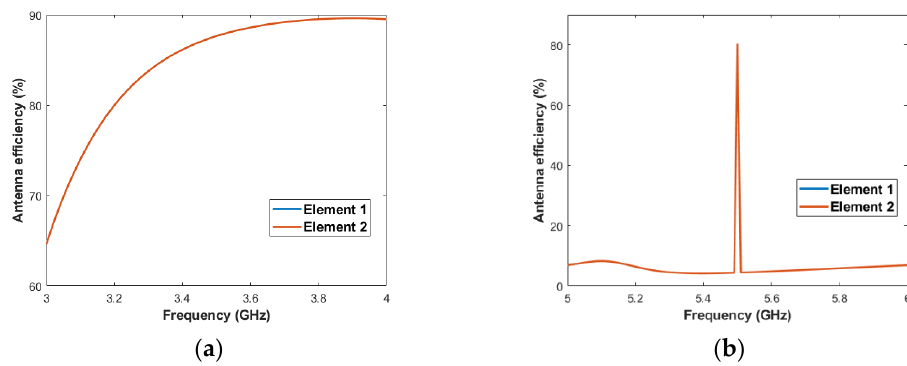
Figure 14. Radiation efficiency results for the ( a ) first and ( b ) second operating bands.